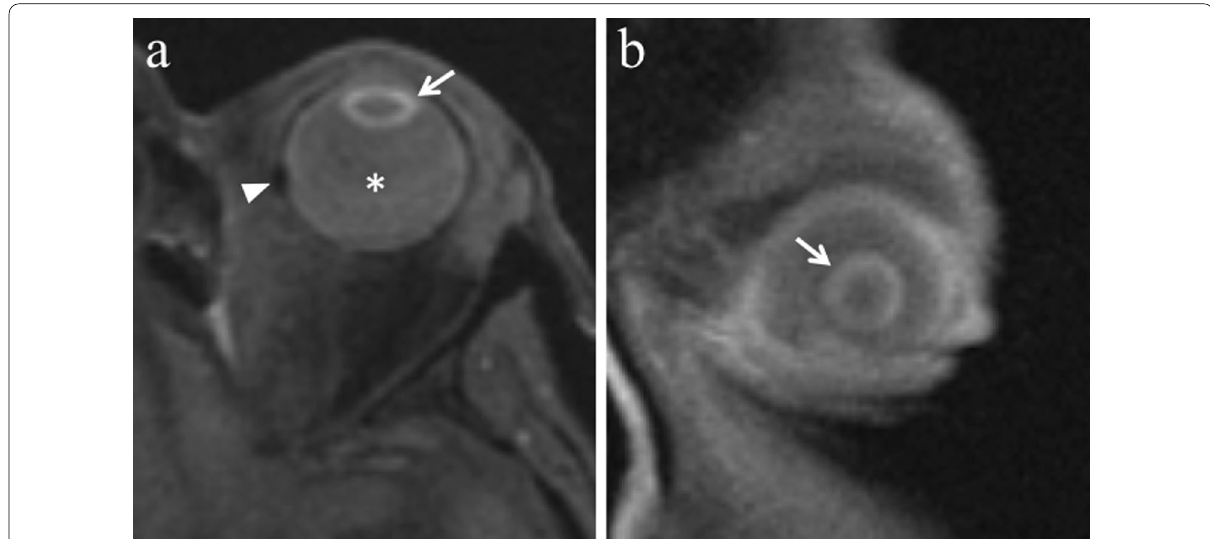
Fig. 11 A 65-year-old man with radiation-induced cataract after proton-beam radiotherapy for choroidal melanoma of the left eye. a Axial and b coronal fat-supressed T1-weighted images show a subcapsular peripheral hyperintense rim of the left lens (white arrows), consistent with radiation-induced cataract. Note the slight hyperintensity of the vitreous body (white asterisk in a ) due to intraocular inflammation. A small metal artefact (white arrowhead in a ), due tantalum clip, is detectable along the medial aspect of the